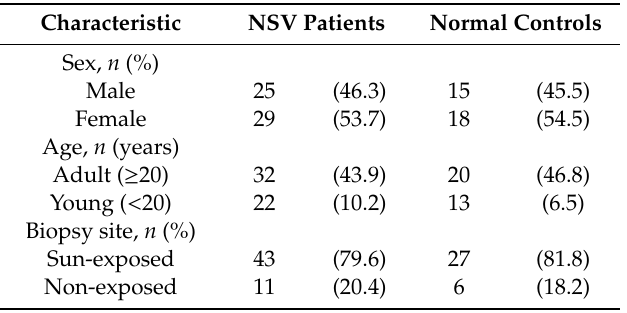
Table 1. Characteristics of NSV patients and normal